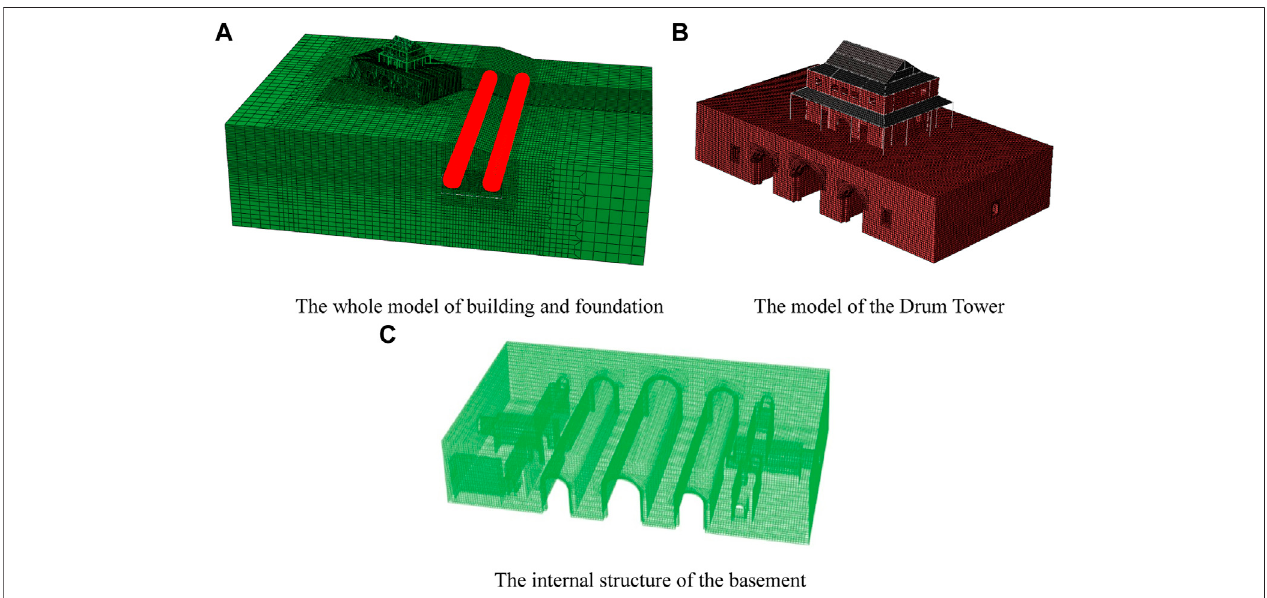
FIGURE 2 | Finite element model of the Nanjing Drum Tower. (A) The whole model of building and foundation. (B) The model of the Drum Tower. (C) The internal structure of the basement.